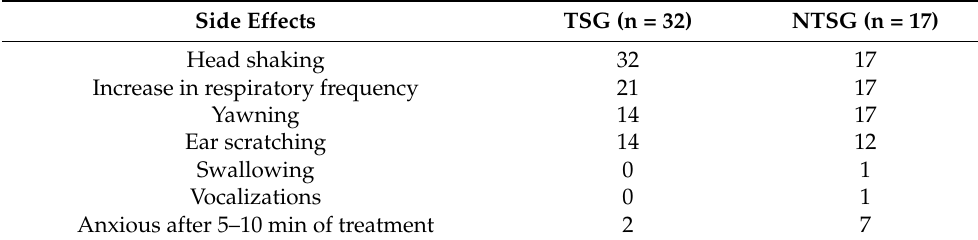
Table 7. Results of the side effects shown in the study